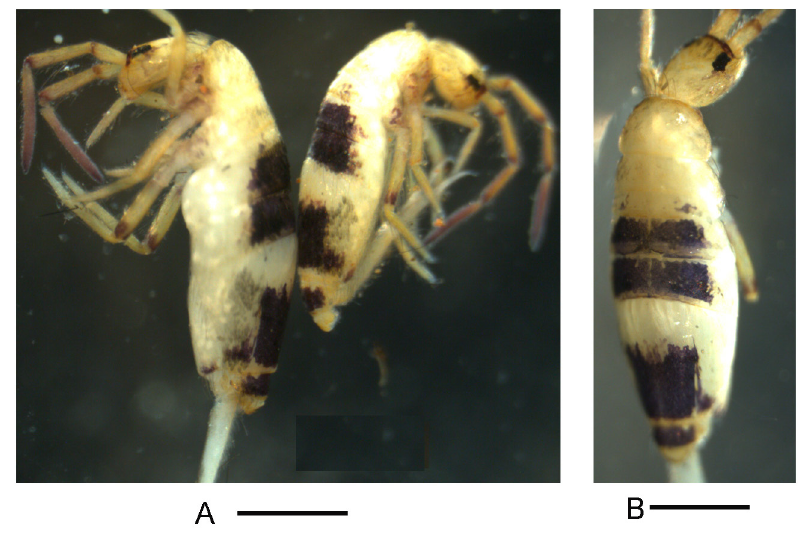
Fig. 4. Willowsia zhaotongensis sp. nov. A−B . Habitus (A = paratype; B = holotype). Scale bars: 500